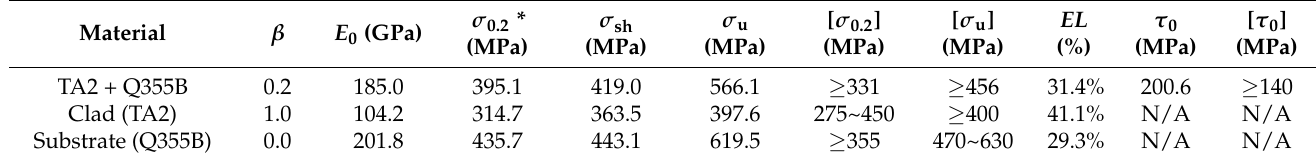
Table 3. Measured mechanical properties of clad, substrate, and TC bimetallic steel [20].